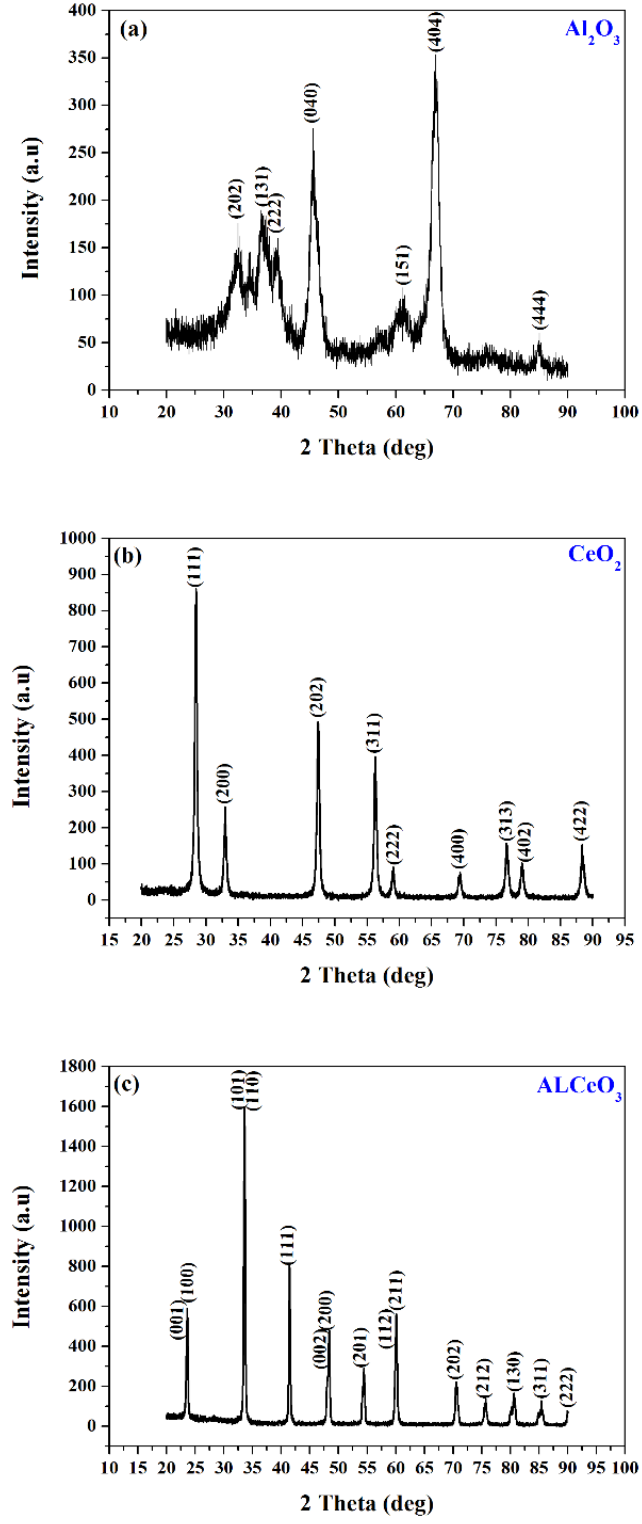
Figure 4. XRD patterns of ( a ) Al 2 O 3 , ( b ) CeO 2 , and ( c ) AlCeO 3